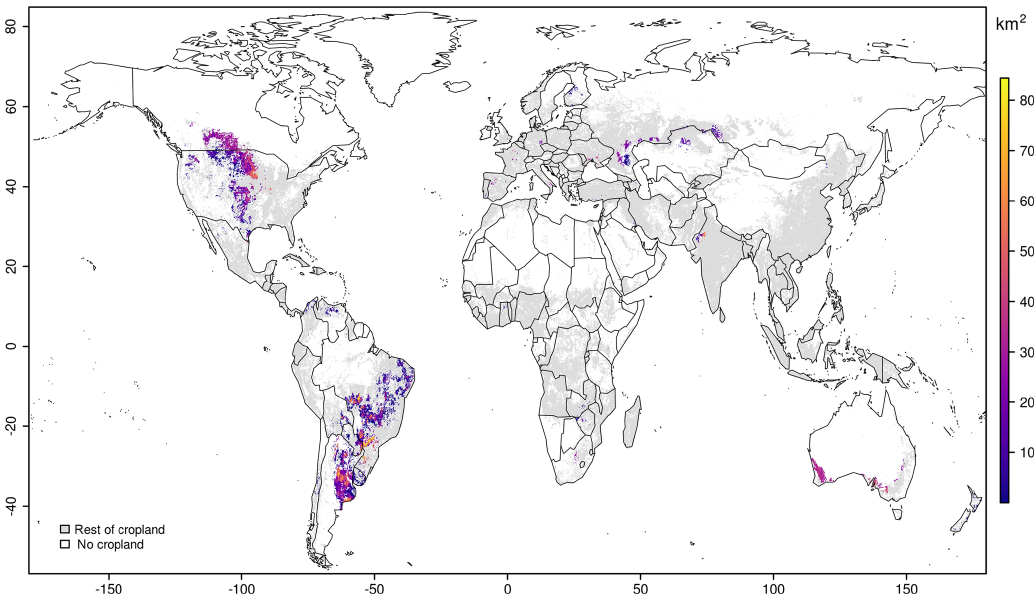
Figure 8. Downscaled Conservation Agriculture area (km 2 ) (colored) on total cropland (grey) per grid cell for 54 reporting countries around the year 2005.